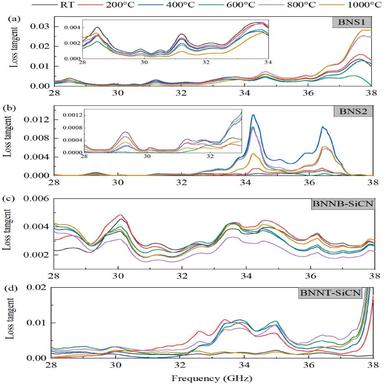
High-temperature free space loss tangent from room temperature to 1000 ◦C over the frequency range from 29.5 to 38 GHz for a) BNS1, b) BNS2, c) BNNB-SiCN, and d) BNNT-SiCN PDC samples.